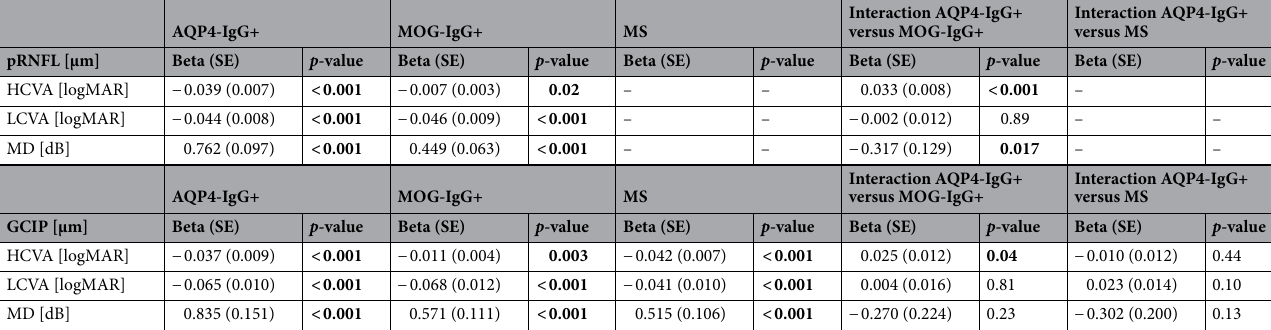
and any measure of visual function was found. In female participants, only in the AQP4-IgG seropositive group significant associations were found (Supplementary Table 2).